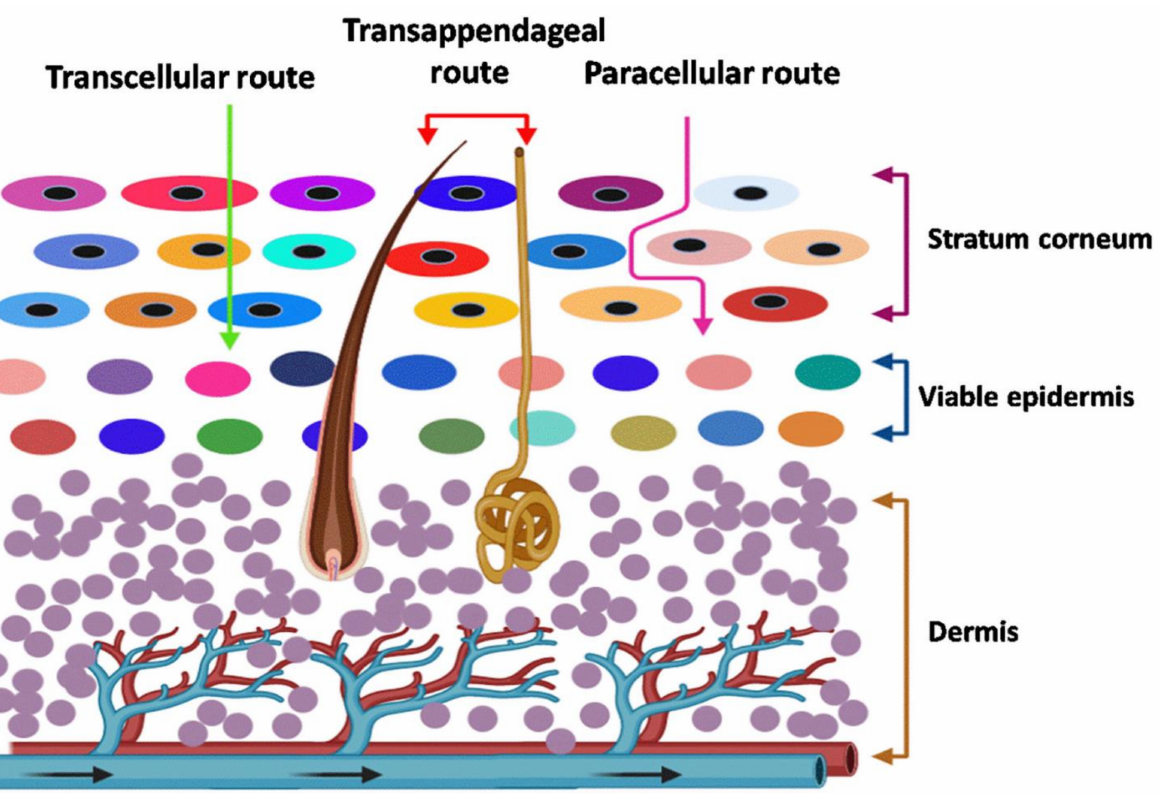
Figure 1. Various pathways of drug transport across the skin (Adapted with permission from [24] published by Elsevier,